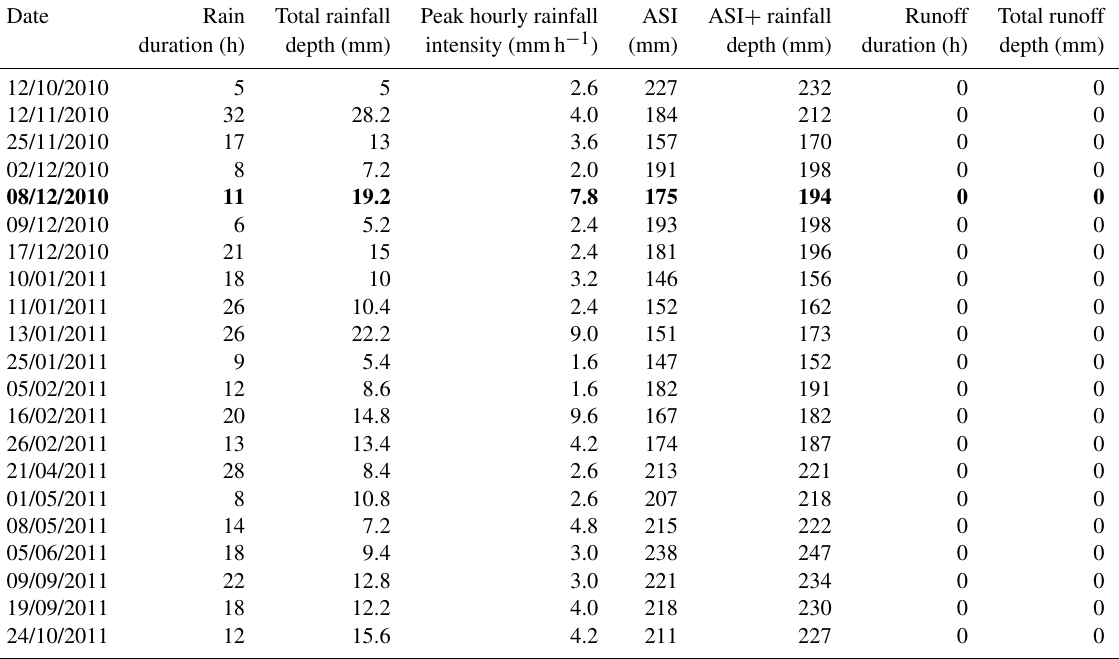
Table 2. Rainfall event summary at RBF with no runoff (Group 1 events). ASI is the Antecedent Soil moisture Index. The events in bold are shown in Fig.